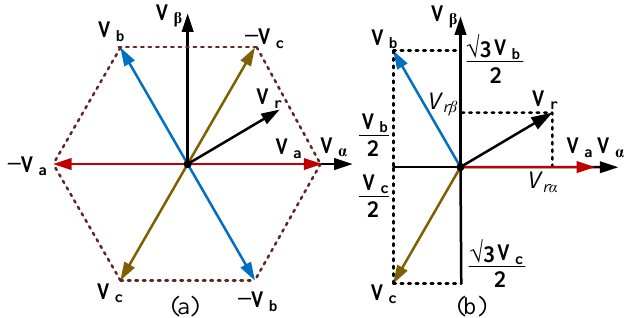
Figure 4. ( a ) The redefined space vectors. ( b ) The vector projection onto the α – β